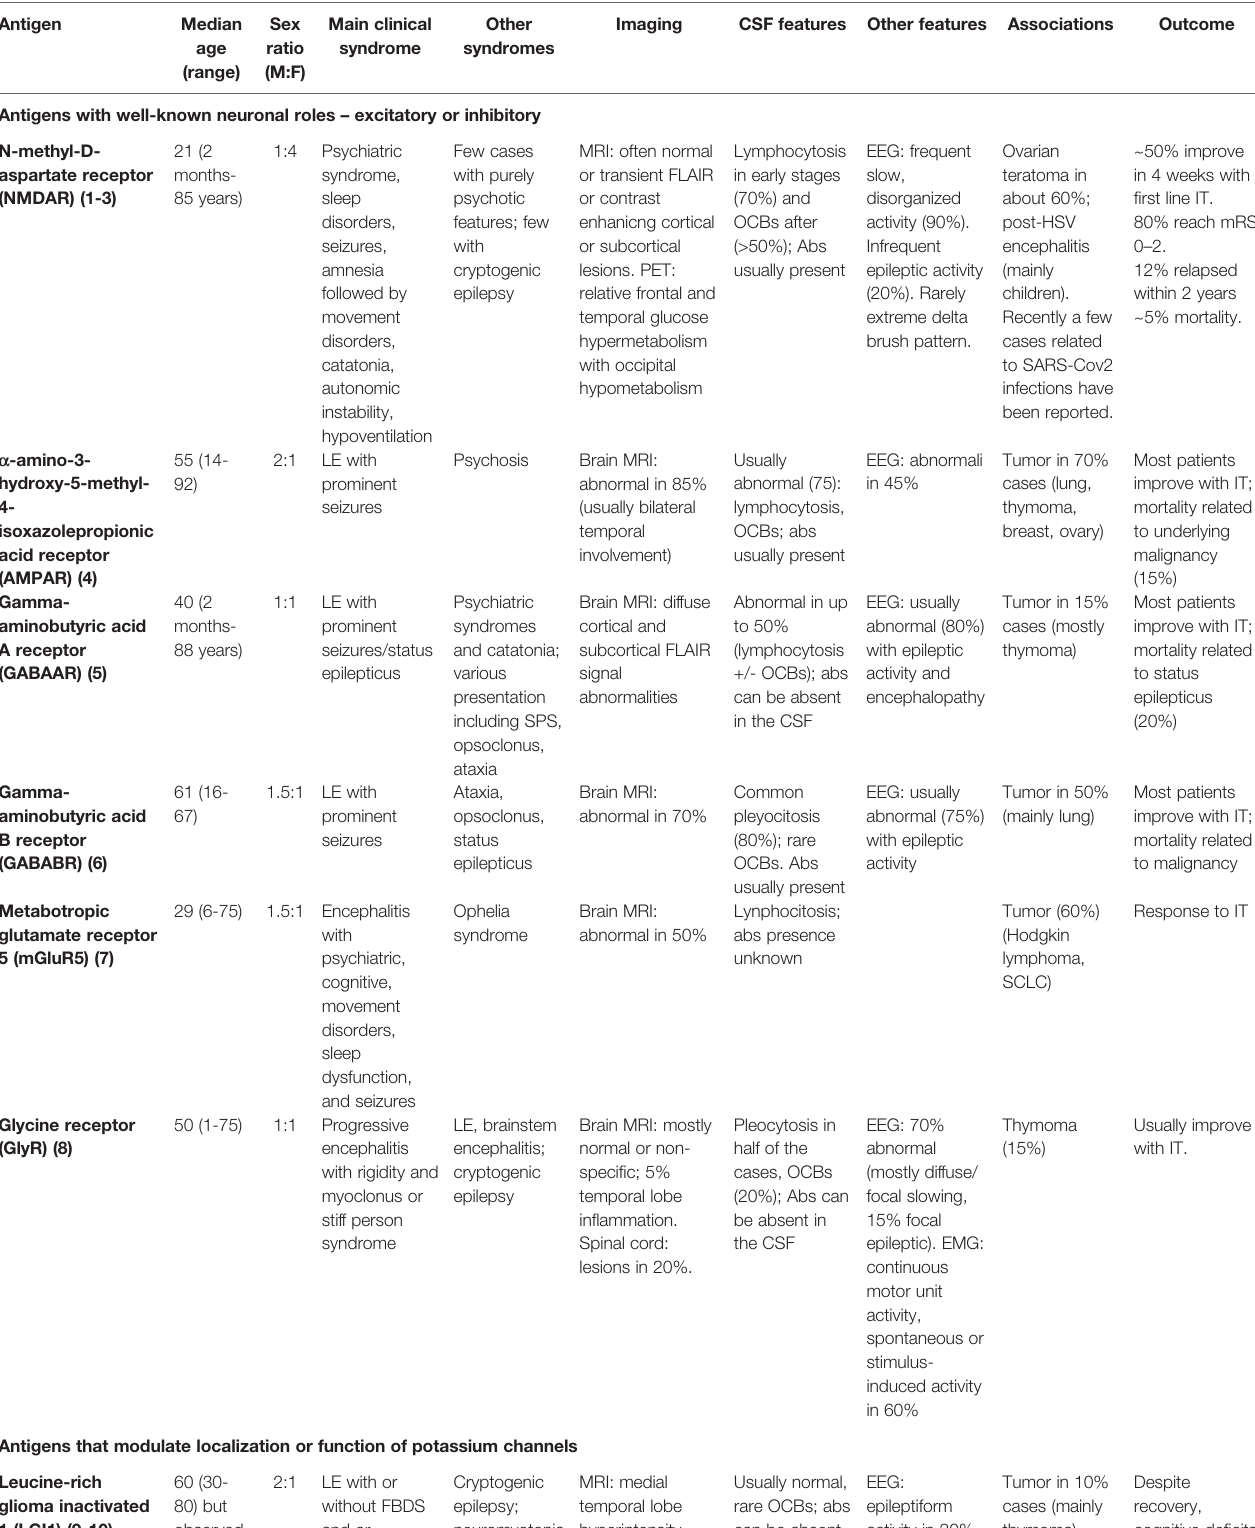
TABLE 2 | Clinical features of main forms of autoimmune encephalitis (AE) associated with known speci fi c antibodies against neuronal surface